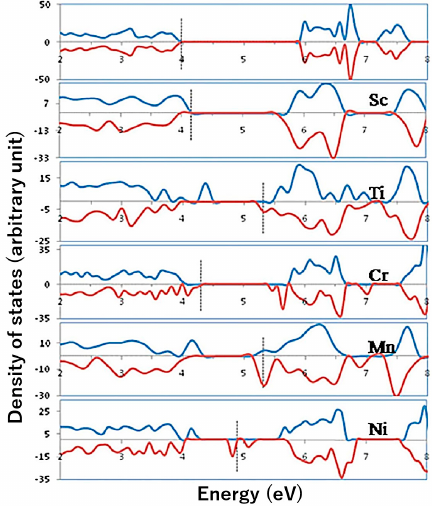
Figure 1. Total electronic DOS plot for pure Fe 2 O 3 and Fe 2 O 3 incorporated with Sc, Ti, Cr, Mn, and Ni at substitutional sites. The states are aligned with respect to the O 1s core level and the highest occupied state is indicated by the dashed vertical line in each case. Adapted with permission from [37]. Copyright 2010 American Institute of Physics Publishing.